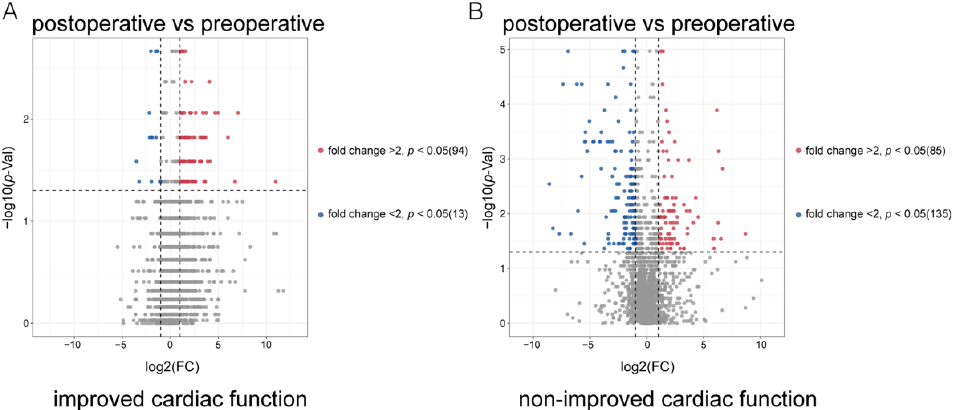
Figure 4. Volcano plot of metabolic profiles in preoperative plasma and post-operative plasma from non-improved cardiac function (nICF) patients and improved cardiac function (ICF) patients: ( A ). Ninety-four metabolites were significantly ( p < 0.05) upregulated (fold change > 2) in ICF patients after LVAD support, and 13 metabolites were significantly ( p < 0.05) downregulated (fold change < 2) in ICF patients after LVAD support. ( B ). Eighty-five metabolites were significantly ( p < 0.05) upregulated (fold change > 2) in nICF patients after LVAD support, and 135 metabolites were significantly ( p < 0.05) downregulated (fold change < 2) in nICF patients after LVAD